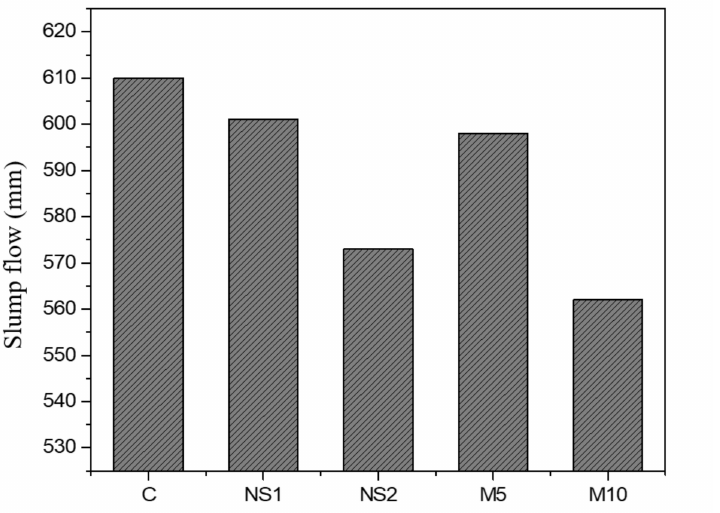
Figure 2. Slump flow results of the underwater concrete (UWC) mixes with different dosages of NS and MgO.